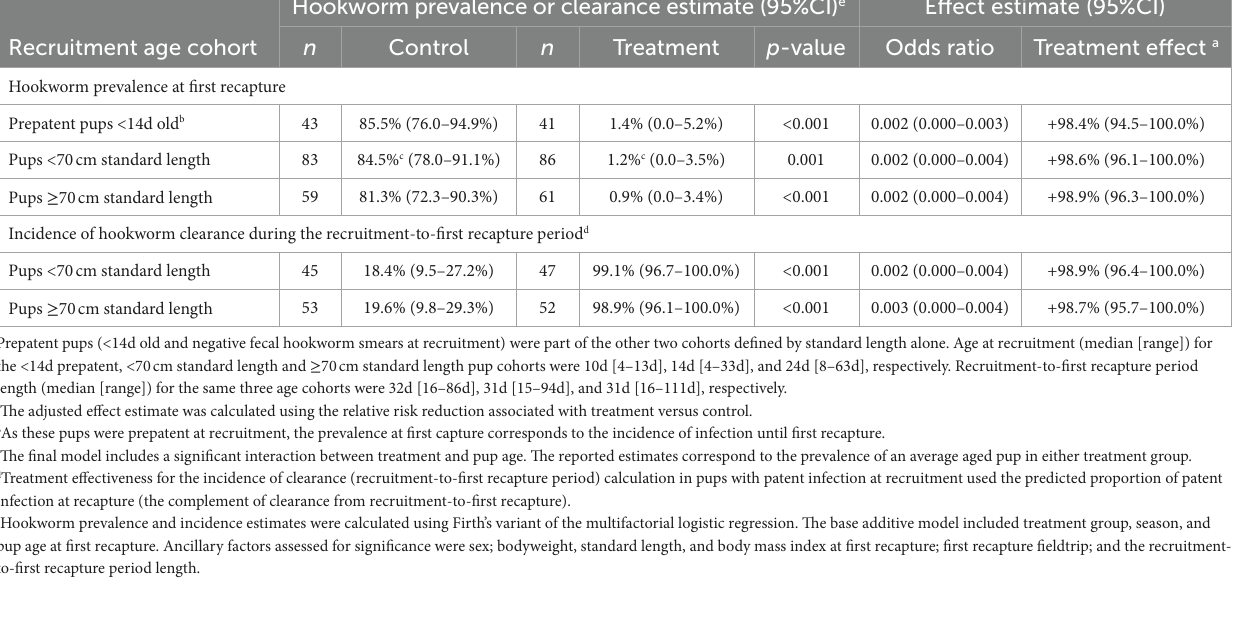
TABLE 3 Adjusted effectiveness of topical ivermectin treatment in Australian sea lion pups for each age cohort using either the hookworm prevalence at first recapture or incidence of hookworm clearance during the recruitment-to-first recapture period.